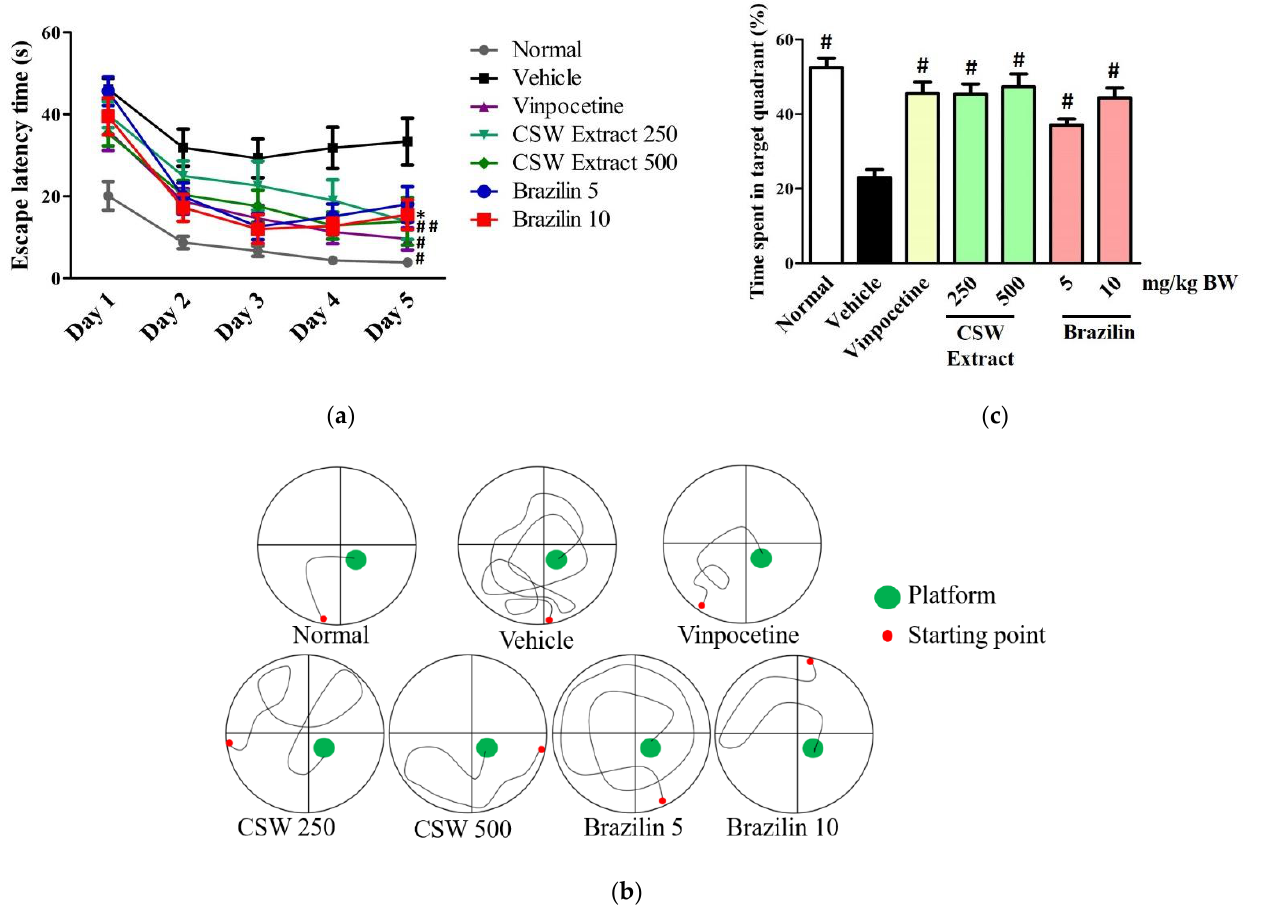
Figure 3. Effect of CSW ethanolic extract and brazilin on the spatial memory of mice in the Morris water maze test. ( a ) Escape latency time in the acquisition phase (days 1 – 5), ( b ) representative swim patterns in the maze (day 5), and ( c ) time spent in the target quadrant in the probe trial (day 6). Data are presented as mean ± SEM ( n = 10) and were analyzed using the Kruskal – Wallis test followed by the Mann – Whitney post-hoc test to assess escape latency time and a one-way ANOVA followed by the Tukey HSD post-hoc test to analyze time spent in the target quadrant. * p < 0.05 and # p < 0.01 indicate significant differences compared to the vehicle (untreated)